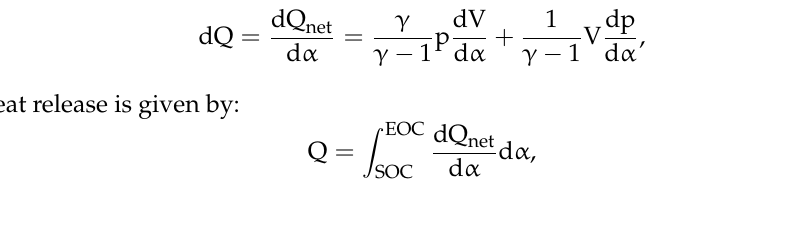
Figure 10. Evaluation of the combustion process at IMEP = 2 bar: ( a ) changes in the extreme combustion pressure values based on the maximum combustion pressure values; ( b ) the heat release rate curve and its value; ( c ) the heat release rate curve for all IMEP values and its maximum-value. The net heat release rate (without heat loss) is determined by applying the first law of thermodynamics using the following equation: